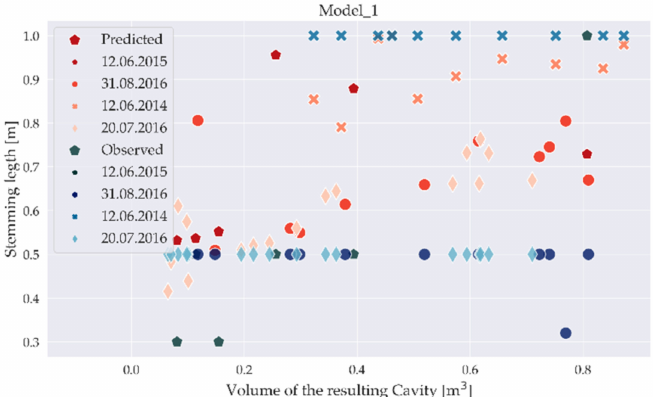
Figure 12. Model_1—Stemming length vs. volume of resulting borehole